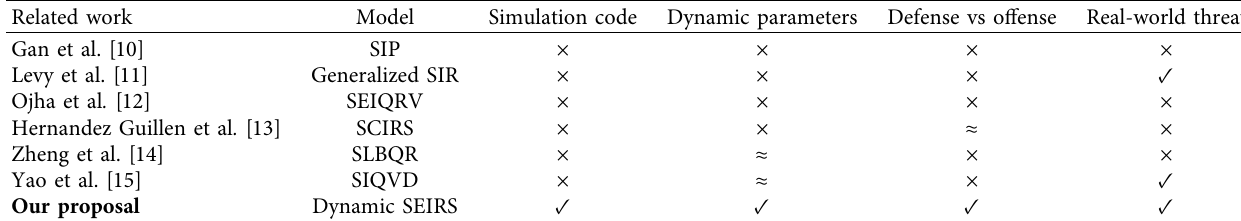
Table 2: Comparison of the related works highlighting the main